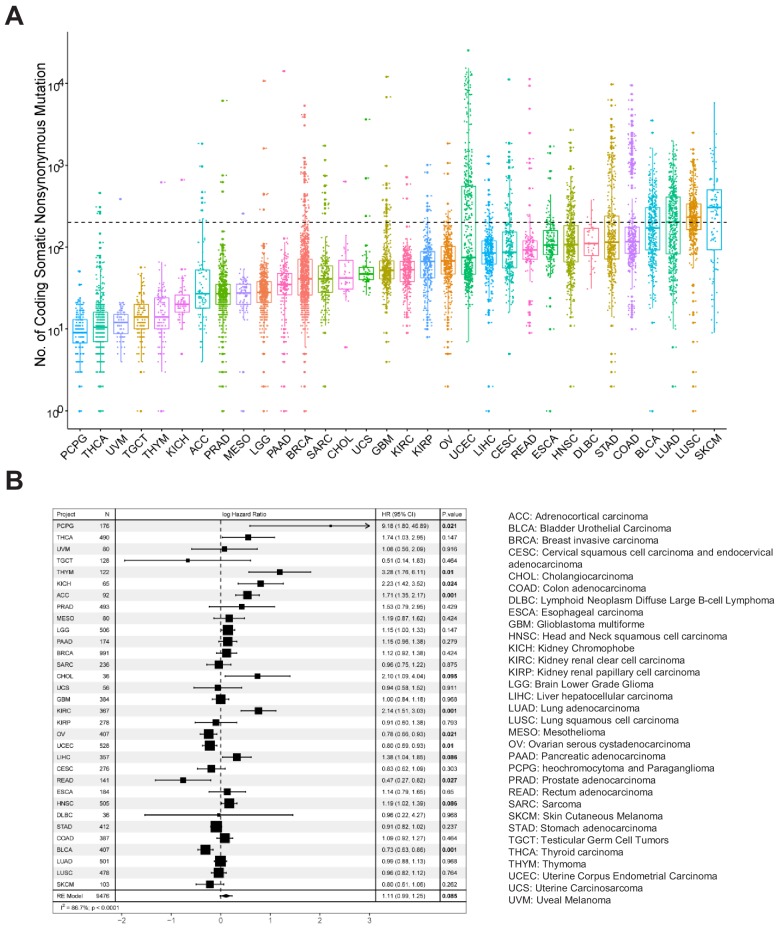
Analysis of tumor mutational burden (TMB) in 32 TCGA cancer types.(A) Number of whole-exome non-synonymous mutation in 32 TCGA cancer types. (B) Results of Cox proportional hazards regression analysis using TMB for all solid cancers. Forest plots showing loge hazard ratio (95% confidence interval). Cox p-values are adjusted with the FDR method. p-values less than 0.1 are in bold. The pooled hazard ratio and p-value are generated by the random effect model. The statistical test for heterogeneity is also shown in the last column. Tumor types are ordered by median TMB values.